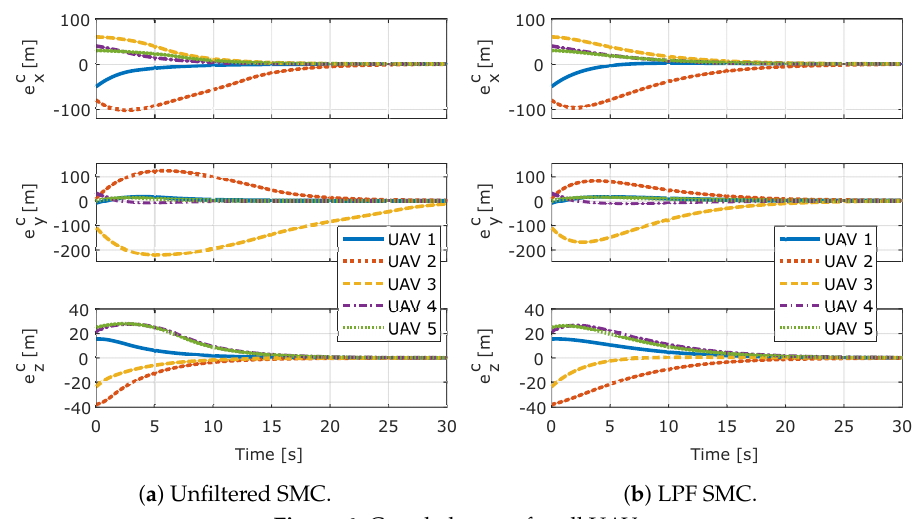
Figure 6. Coupled errors for all UAVs.